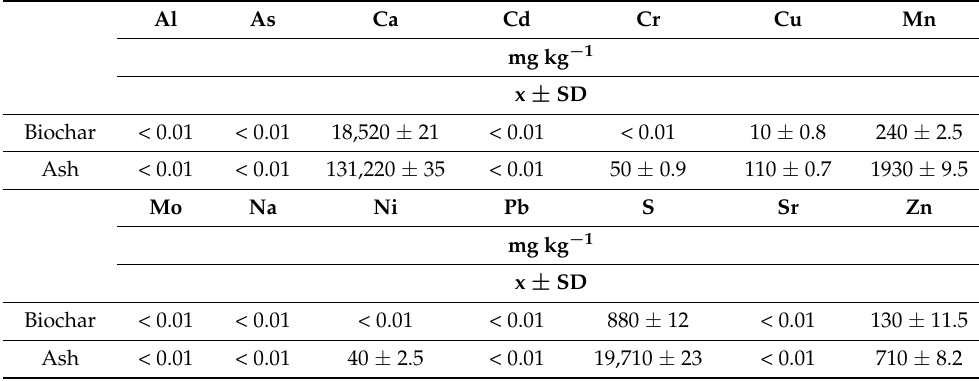
Table 3. Contents of selected macro- and microelements in biochar and ash from biomass.